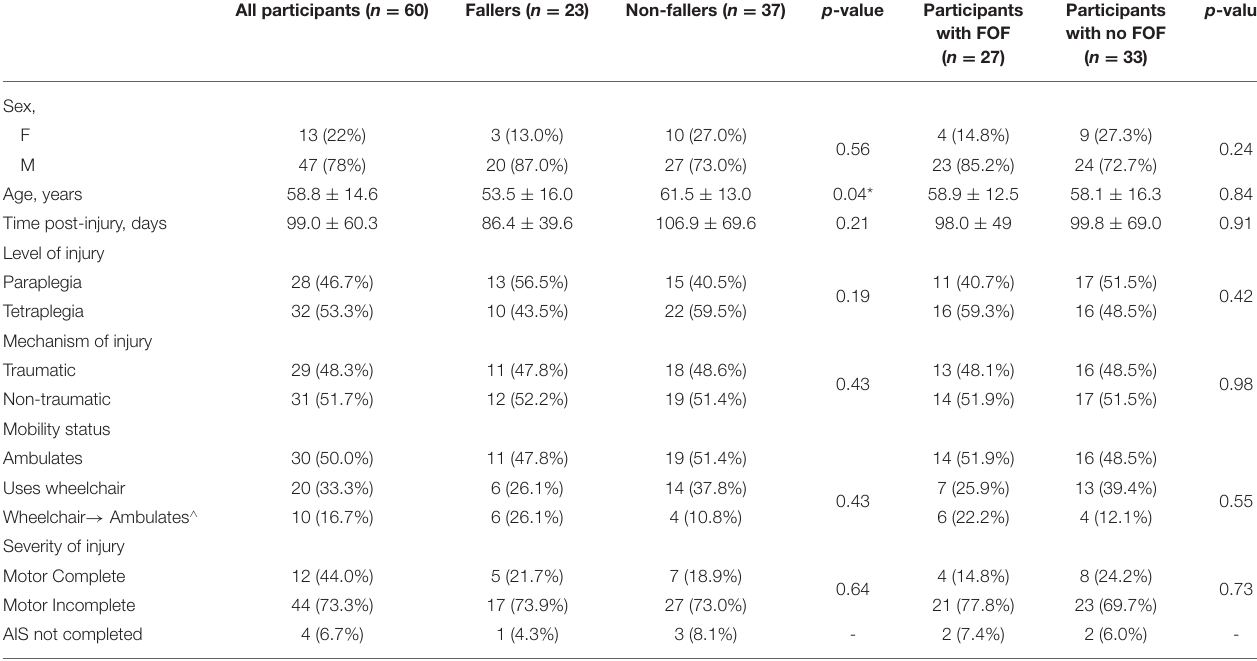
TABLE 1 | Participant